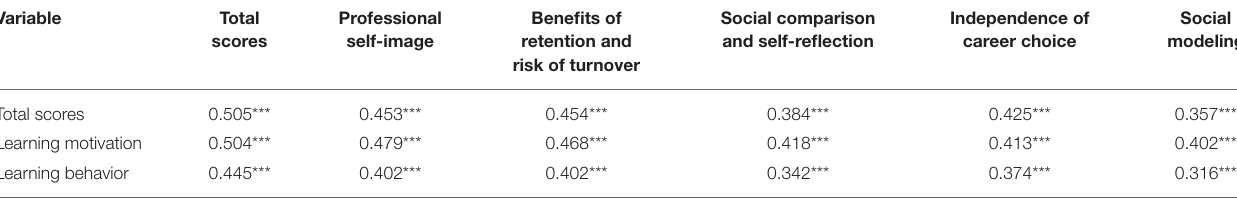
TABLE 3 | The correlation between the E-learning adaptability and professional identity dimensions ( r ).